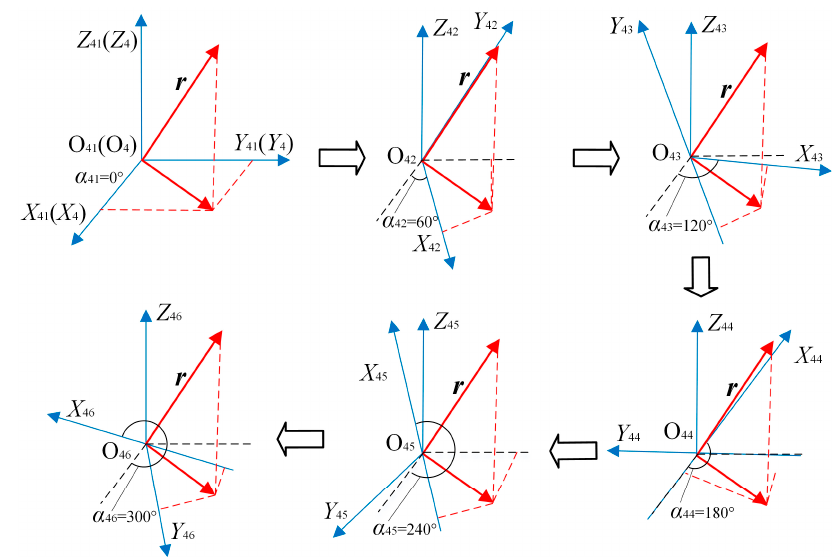
Figure 5. The illustration of the transformation of the multi-re fl ector’s coordinate systems.